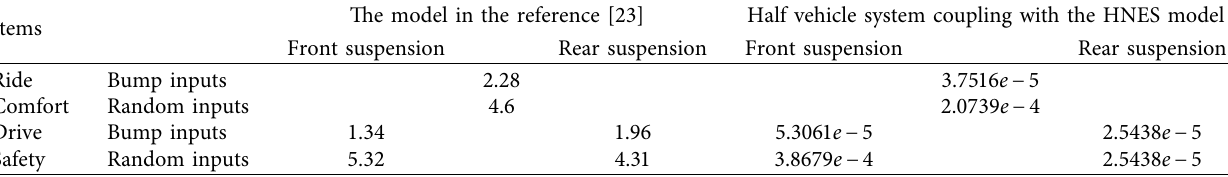
Table 4: Comparison of both ride comfort and drive